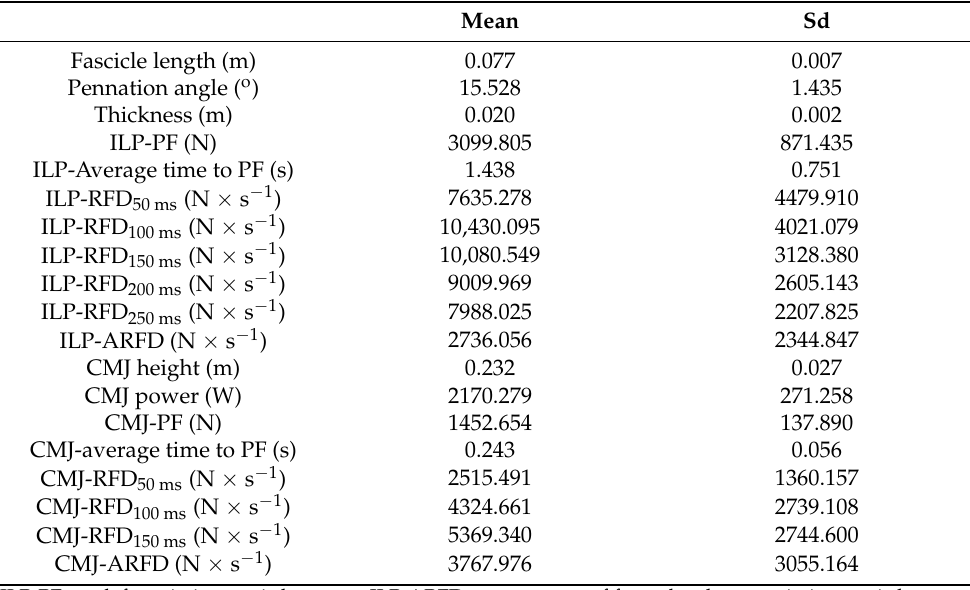
Table 1. Means and standard deviations of the examined variables (n =